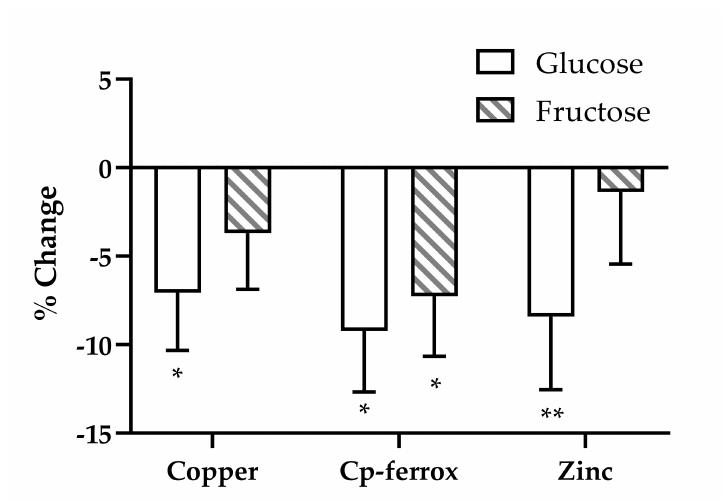
Figure 1. Estimates of the e ff ects of fructose and glucose on the percentage changes of serum copper, Cp-ferrox, and zinc in subjects consuming beverages containing fructose, glucose, HFCS, or aspartame for 2 weeks. General linear model ANCOVA with beverage interventions described as the proportional contents of fructose and glucose as separate variables. Model included adjustments for BMI and sex.